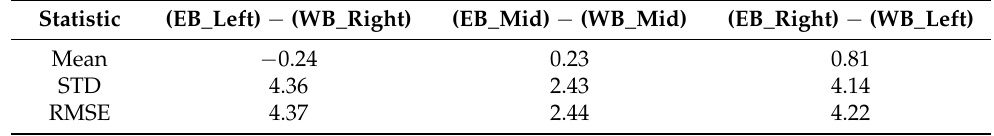
Table 7. Intensity profile difference statistics for WB and EB segments (length: 4.6